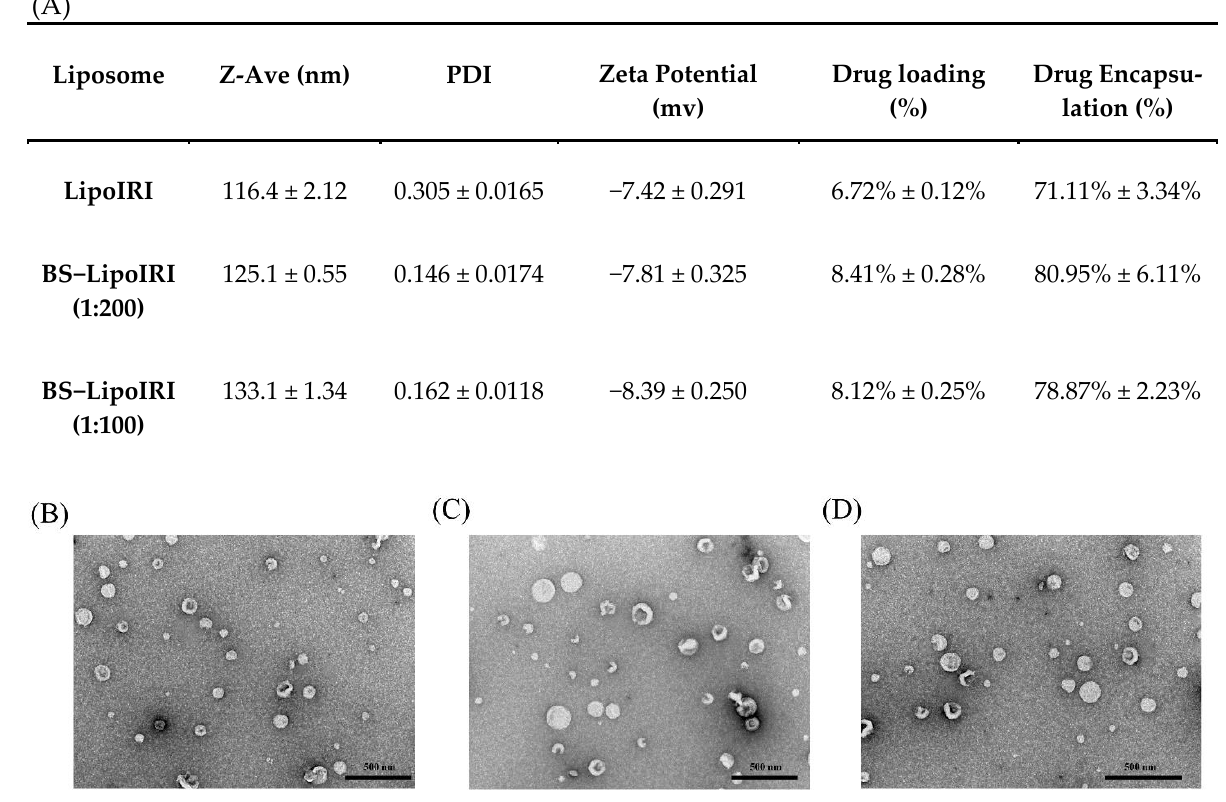
Figure 1. ( A ) Physicochemical characteristics of LipoIRI, BS − LipoIRI (1:200), and BS − LipoIRI (1:100). TEM images of ( B ) LipoIRI, ( C ) BS − LipoIRI (1:200), and ( D ) BS − LipoIRI (1:100). Results are expressed as mean ± SE of three independent experiments.